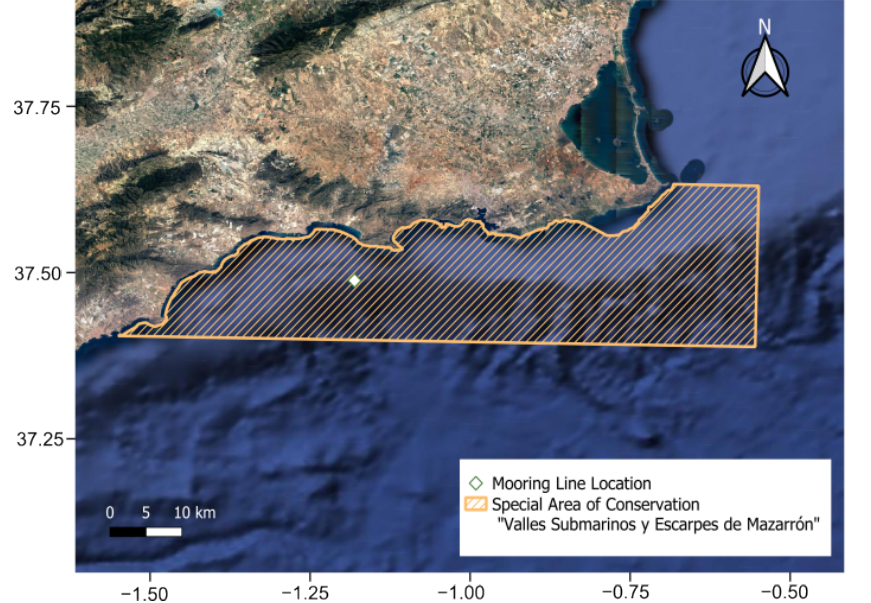
Figure 1. Detail of the mooring line location within the special area of conservation “Valles submari- nos del Escarpe de Mazarrón”.